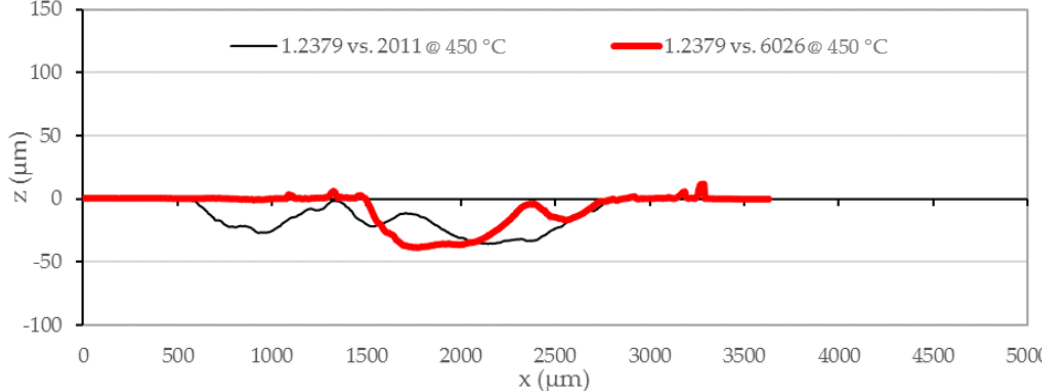
Figure 13. Depth profile of the track. Test carried out at 450 °C with 1.2379 and both 2011 and 6026.